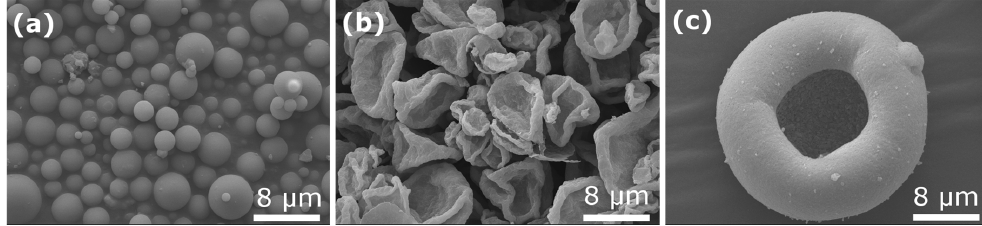
Figure 2. Examples of morphology of as-sprayed granules: ( a ) precursor of Na 3 V 2 (PO 4 ) 2 F 3 , spray-drying of aqueous solution, bi-fluid nozzle atomization; ( b ) same as ( a ) with addition of carbon nanotubes in the solution; ( c ) silicon, spray-drying of suspension in alcohol, fountain mode. All three micrographs are unpublished scanning electron microscope (SEM) micrographs from the authors’ own work.